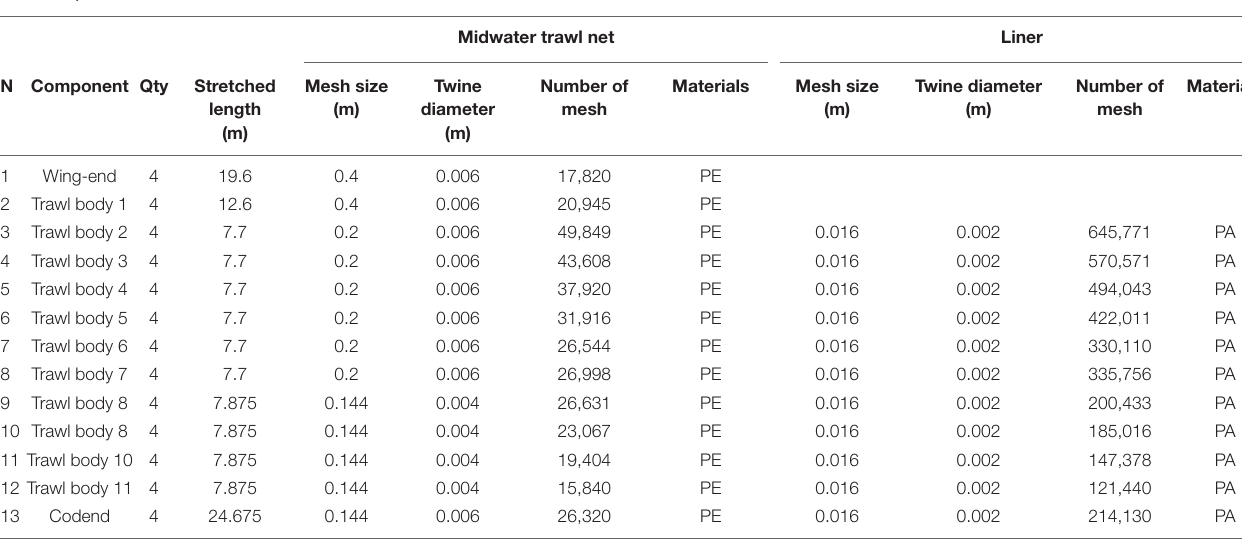
TABLE 1 | Characteristics of the full-scale Antarctic krill trawl net.